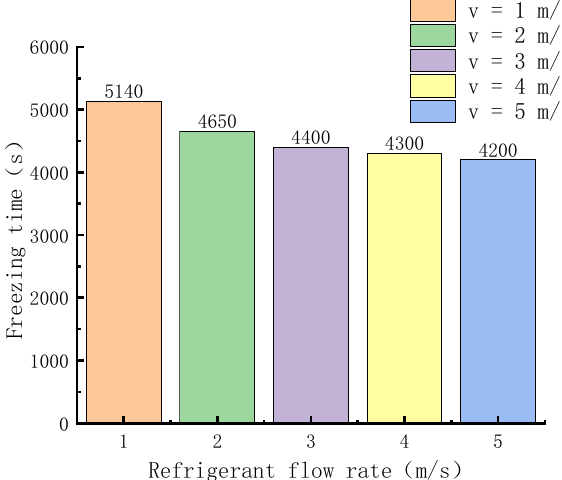
Figure 7. Bar chart of refrigerant flow rate and freezing time.